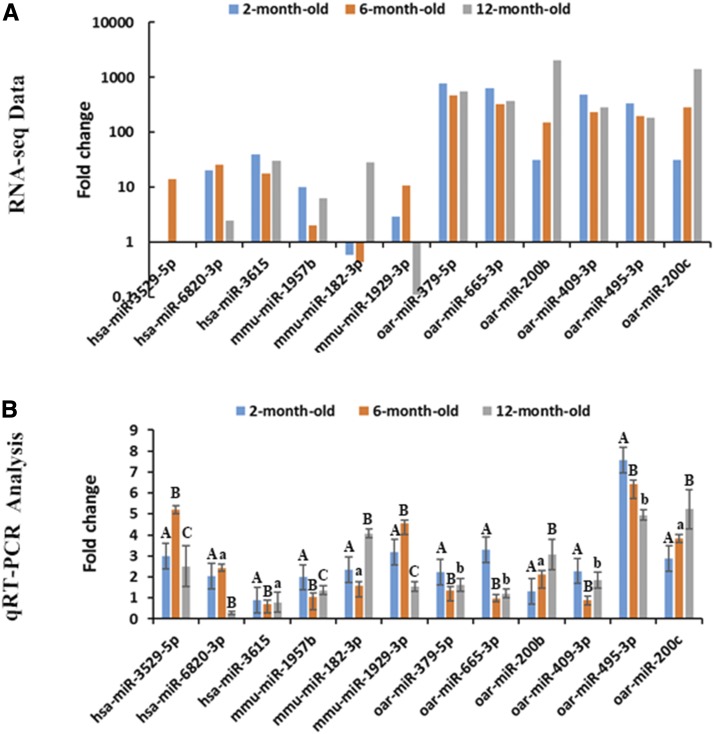
qRT-PCR validation of RNA-seq data for miRNAs. a. RNA-seq data. Values were calculated and normalized by EB-Seq algorithm if the fold changes were >1.5 and FDR < 0.05. b. RT-PCR analysis of 6 novel miRNAs and 6 known miRNAs. The fold change in each time point was relative to 2 months. The expression values were calculated by the 2−ΔΔCt method. Different capital letters represent extremely significant differences (P < 0.01); different letters indicate significant differences (P < 0.05), whereas the same letters indicate no significant differences (P > 0.05).